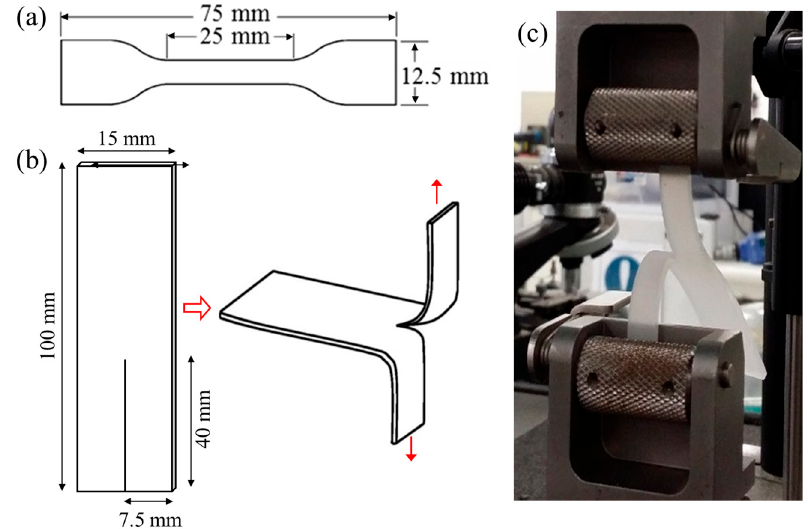
Figure 2. ( a ) Type-2 dumbbell specimen for tensile testing according to AS 1683.11-2001, ( b ) trouser specimen for tear testing according to AS 1683.12-2001, ( c ) self-tightening grips with the trouser specimen in the machine.